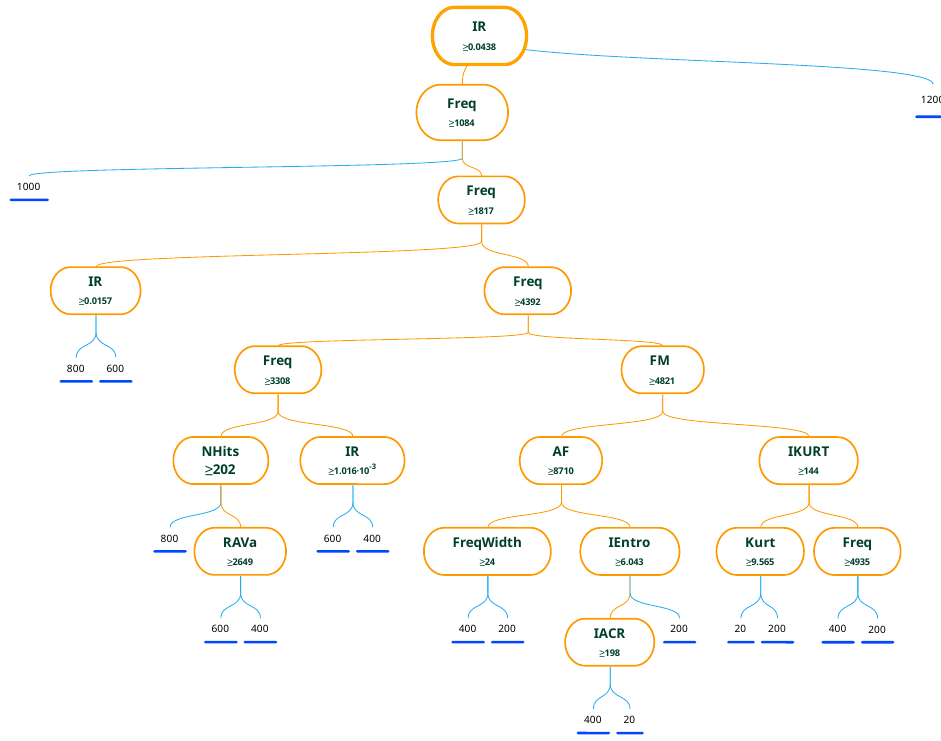
Figure 18. Decision tree of optimized bagged tree